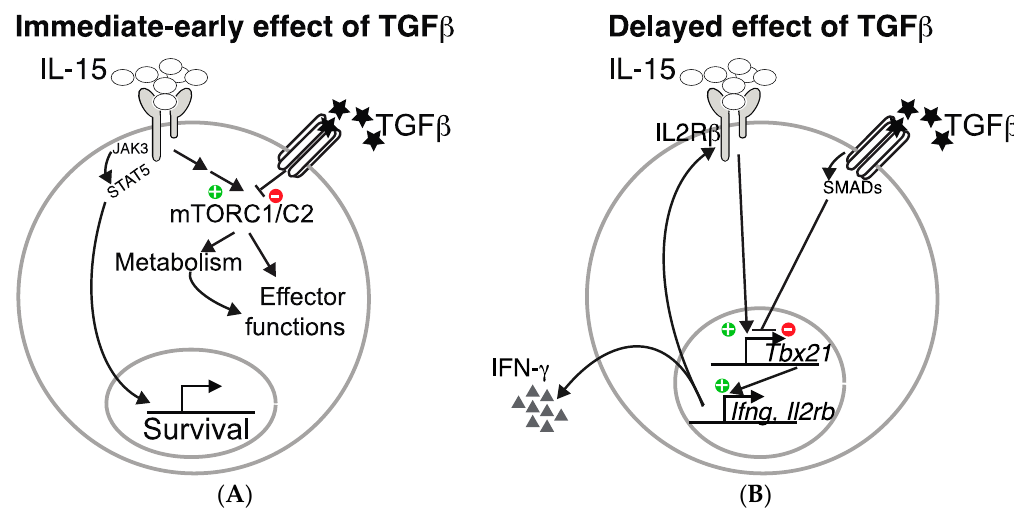
Figure 1. TGF- β inhibits IL-15-driven natural killer (NK) cell effector functions at two distinct levels. TGF- β inhibits IL-15 induced mTORC1/2 activation and the subsequent metabolic increase as well as effect on effector functions ( A ). In addition, it also inhibits the transcription of Tbx21, an IL-15 target, thus resulting in decreased IFN- γ production and IL2R β level ( B ).